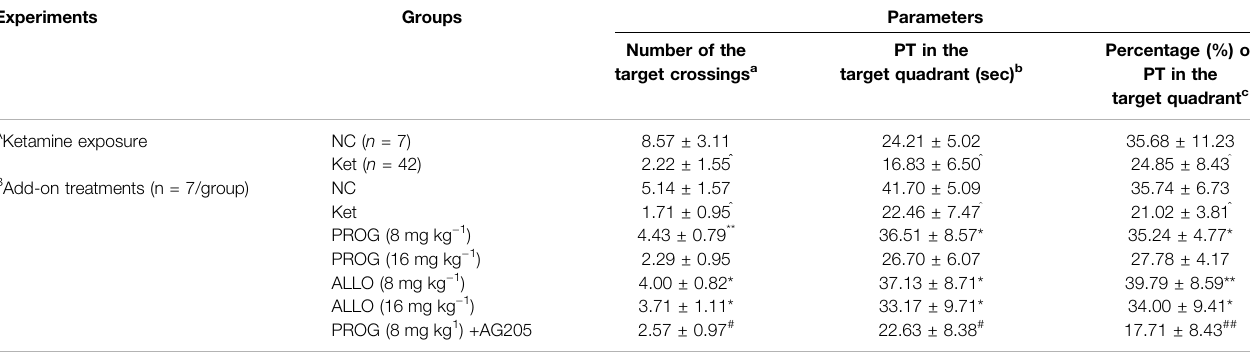
TABLE 1 | Parameters of the probe trial in MWM test (mean ± SD).